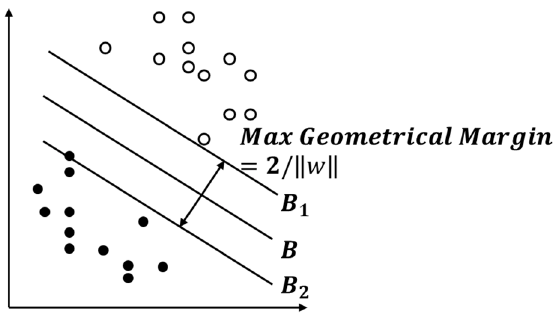
Figure 4. Support vectors and optimal hyperplane of a linearly separable case.